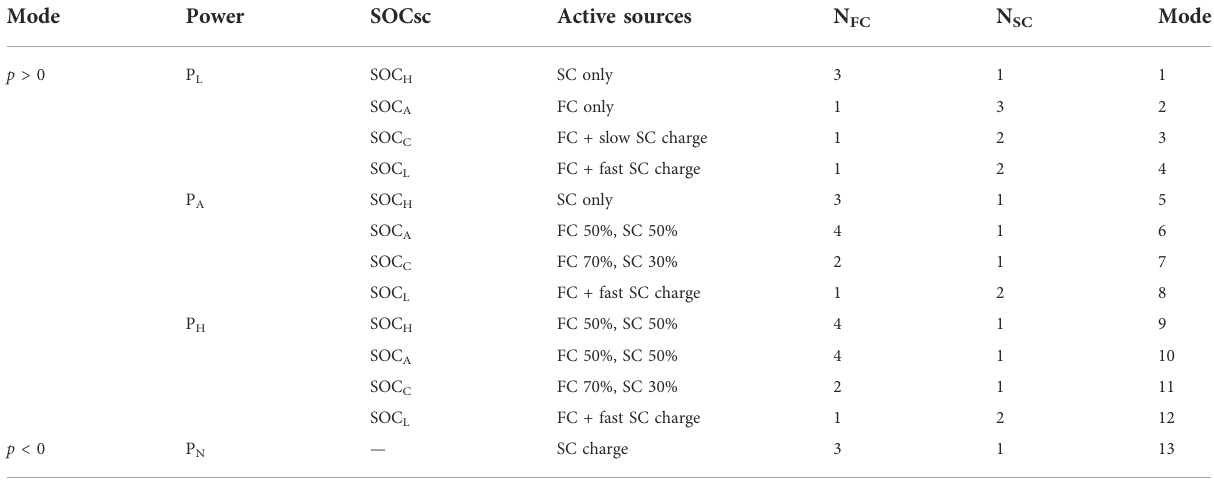
TABLE 4 Different driving rules.